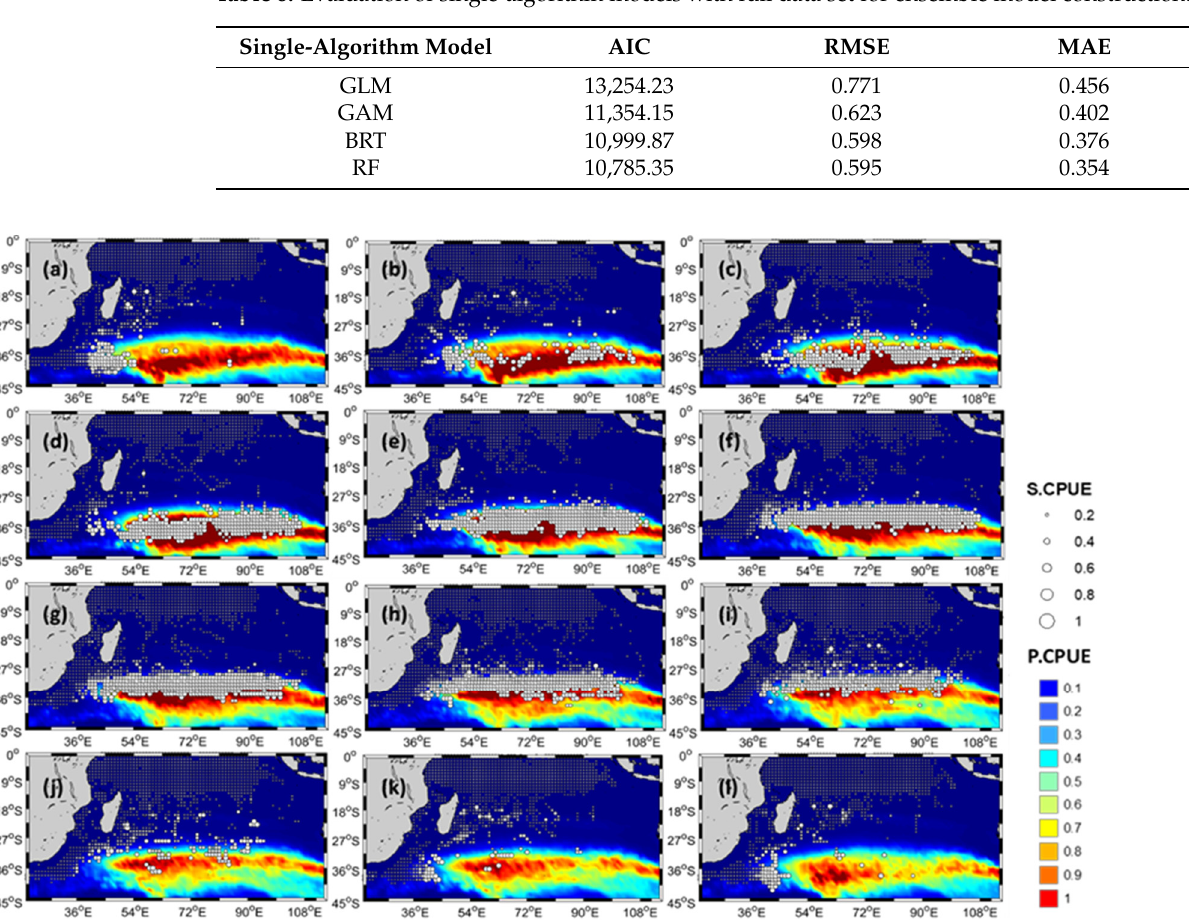
Figure 4. Monthly three-dimensional spatial distribution of immature albacore tuna in Indian Ocean from 1998 to 2016. ( a ) January, ( b ) February, ( c ) March, ( d ) April, ( e ) May, ( f ) June, ( g ) July, ( h